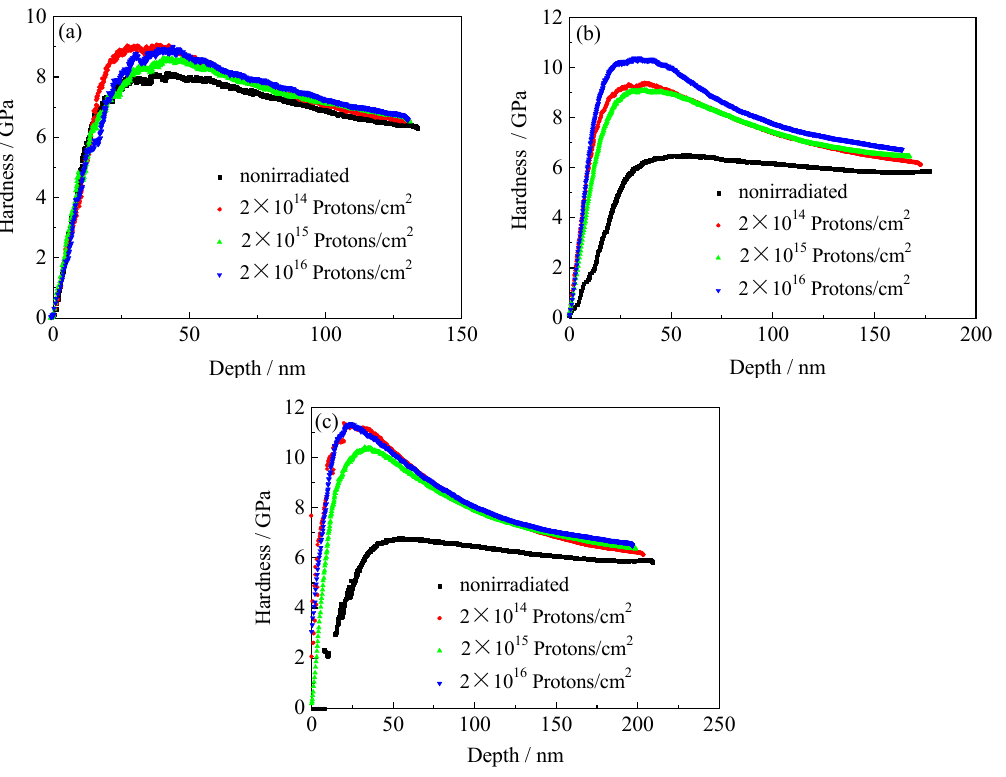
Figure 11. Variation of indentation hardness of tempered 5140 alloy steel tempered at 480 °C with depth under different loads before and after proton irradiation: ( a ) 4000 µN, ( b ) 6000 µN, ( c ) 8000 µN.